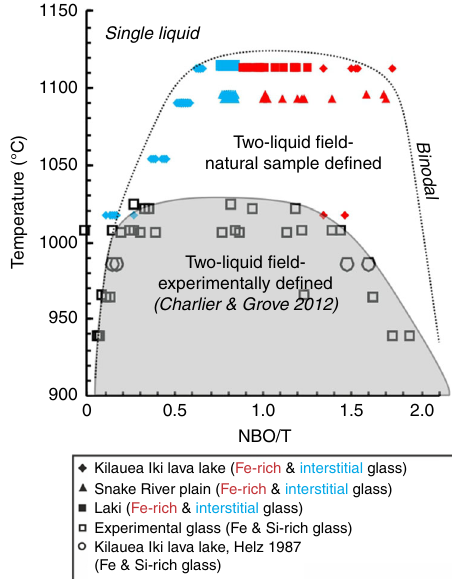
Fig. 5 The silicate liquid immiscibility fi eld. Temperature as a function of the degree of polymerisation (NBO/T: NBO non-bridging oxygens and T = Si + Al + P + Ti), calculated from EPMA data on the glasses. The shaded grey region represents the experimentally de fi ned two-liquid fi eld 12 , the dotted line represents the maximum compositional space where the natural examples show evidence of unmixing by a compositional boundary